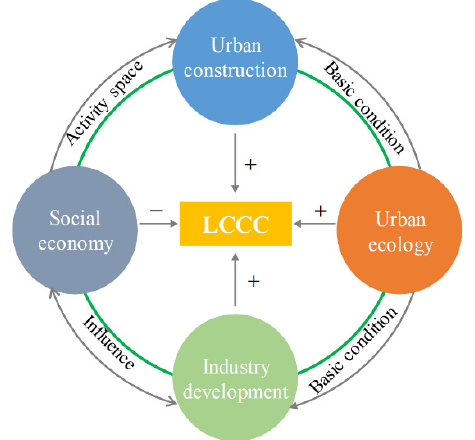
Figure 1. Subsystem interactions of LCCC.